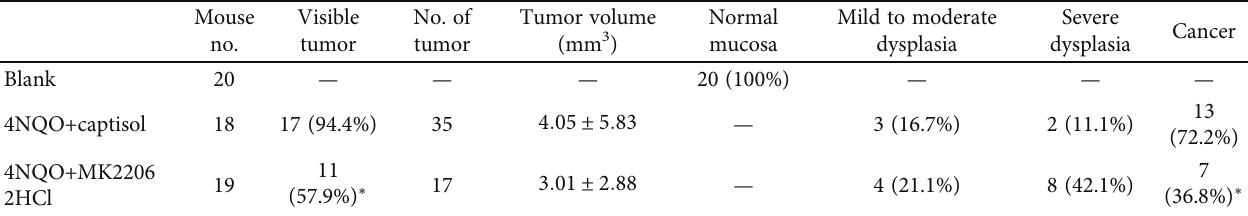
Figure 2: The applications and e ff ects of MK2206 2HCl on the 4NQO-induced mouse oral carcinogenesis model. (a) Experimental protocol for the chemopreventive e ff ect of MK2206 2HCl on 4NQO-induced mouse oral carcinogenesis model. (b) Mouse body weight. ∗∗ P < 0 : 01, ∗ P < 0 : 05 as compared with the blank group. (c) Gross tumors and lesions in mouse tongues at the end of the 24th week. The tumors are indicated by arrows. Bar = 1 cm. Table 1: Chemopreventive e ff ect of MK2206 2HCl on 4NQO-induced mouse oral